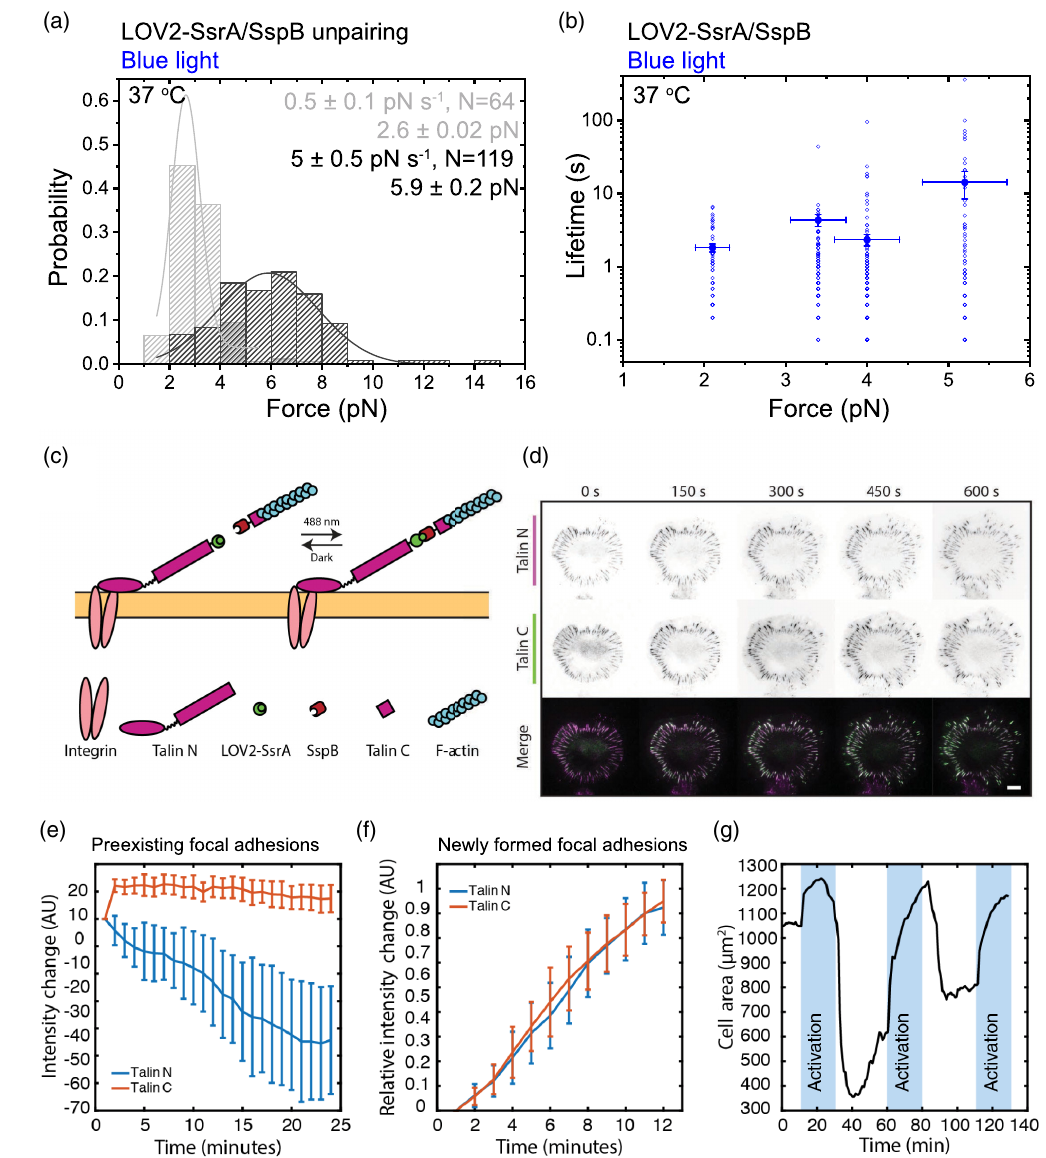
FIG. 7. Modulation of talin-mediated mechanotransduction using iLID-nano. (a) Normalized histograms of LOV2-SsrA/SspB complex unpairing forces obtained at force-loading rates of 0 . 5 (cid:1) 0 . 1 (light gray) and 5 (cid:1) 0 . 5 pN s − 1 (gray) in blue light at 37 °C. The curves are Gaussian fitting curves. (b) Force-dependent lifetimes of LOV2-SsrA/SspB complex in blue light. (a) and (b) are obtained in the absence of FMN in solution. The solid blue squares indicate the mean lifetime at a force, while the hollow blue circles represent individual lifetimes measured. Over 50 lifetimes are measured for each force. The horizontal error bars indicate 10% of relative force calibration uncertainty of the system (see Sec. IV). The vertical error bars indicate standard errors. (c) Illustration of the modification on the talin-1 protein using iLID-nano. (d) The changes in cell morphology and FA profiles after blue-light switch on for the iLID-nano system. Scale bar, 10 μ m. (e). Engagement of the talin C terminus upon activation of blue light based on ten focal adhesions. (f) Recruitment of talin N and C termini at the same rate in ten new focal adhesions. (g) Change in cell area from Supplemental Movie S2 [37] when exposed to pulsing blue light. Error bars indicate the standard